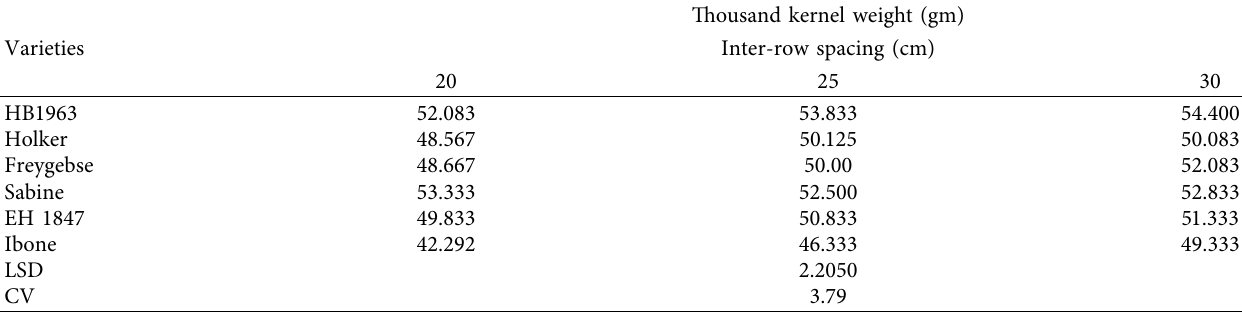
Table 6: Interaction effect of varieties with inter-row spacing and variety with location on thousand kernel weight of malt barley at Debark, north Gondar, Ethiopia, in